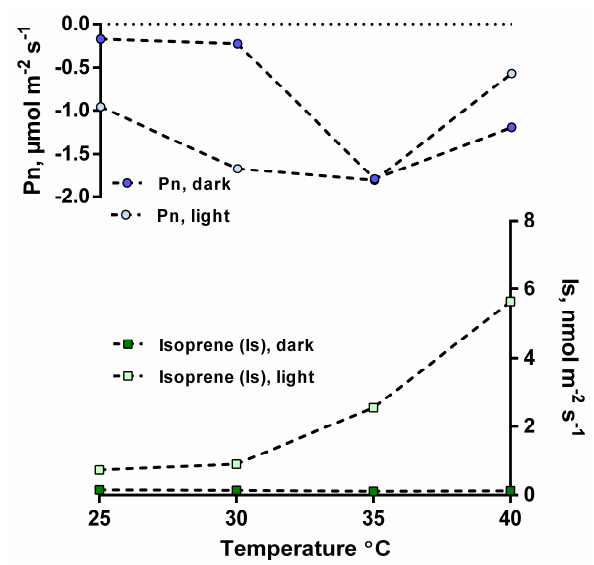
Figure 6. Leaf isoprene emissions ( Is , nmol m − 2 s − 1 ) and net photosynthesis rates ( Pn, µ mol m − 2 s − 1 ) from an I. edulis leaf as a function of temperature under CO 2 -free atmosphere, in the presence and absence of light (PPFD intensity 1000 µ mol m − 2 s − 1 ) ( n = 1).